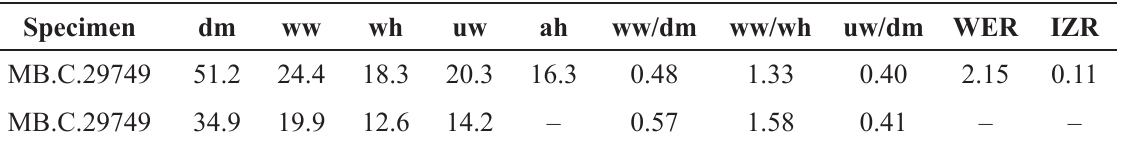
Table 9. Conch dimensions (partly estimated) and ratios of selected specimens of Paratirolites rubens Korn & Hairapetian sp. nov. from Baghuk Mountain.